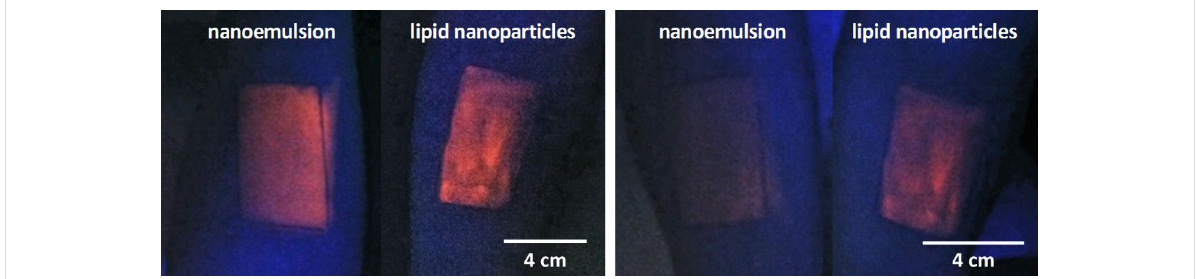
Figure 6: Left: Nile red-labeled lipid nanoparticle suspension (right arm) and nanoemulsion (left arm) applied to human forearm directly after applica- tion. Right: B oth arms after washing under flowing water with rubbing. The lipid nanoparticles are highly adhesive and mostly remain on the skin (right